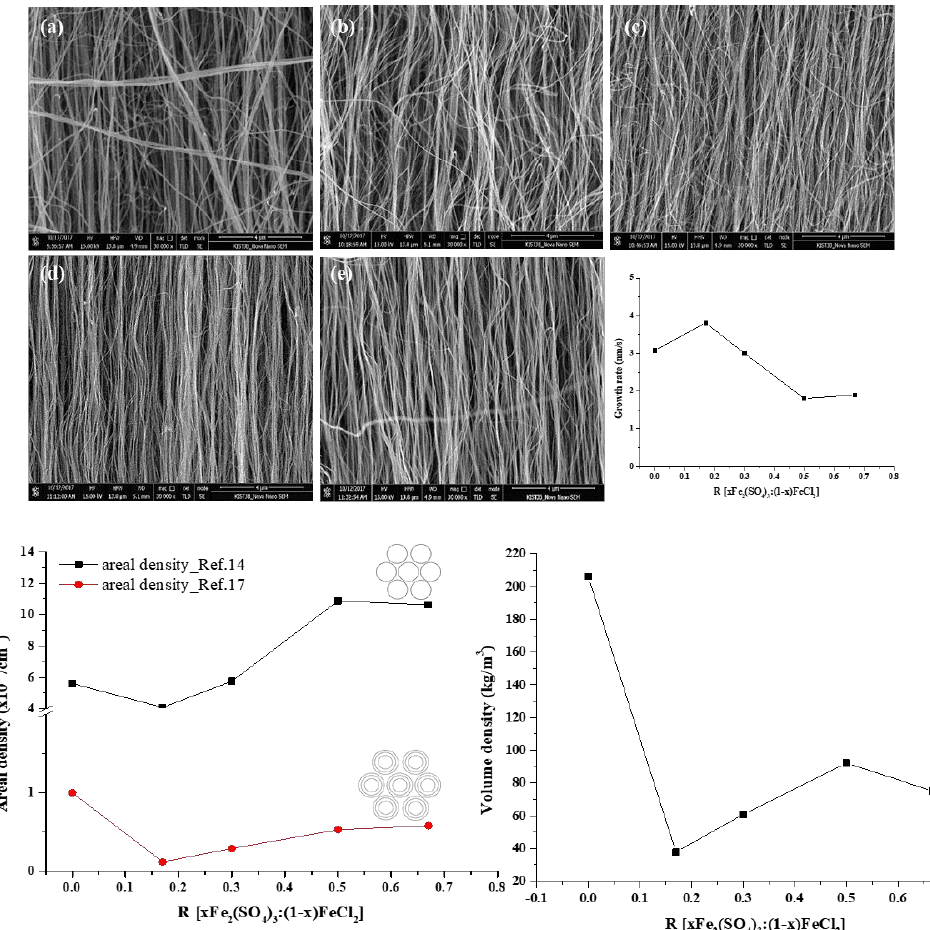
Figure 1. SEM images and areal and volume density of the carbon nanotube (CNT) forests synthesized with various R values; ( a ) R = 0, ( b ) R = 0.17, ( c ) R = 0.3, ( d ) R = 0.5, and ( e ) R = 0.67.